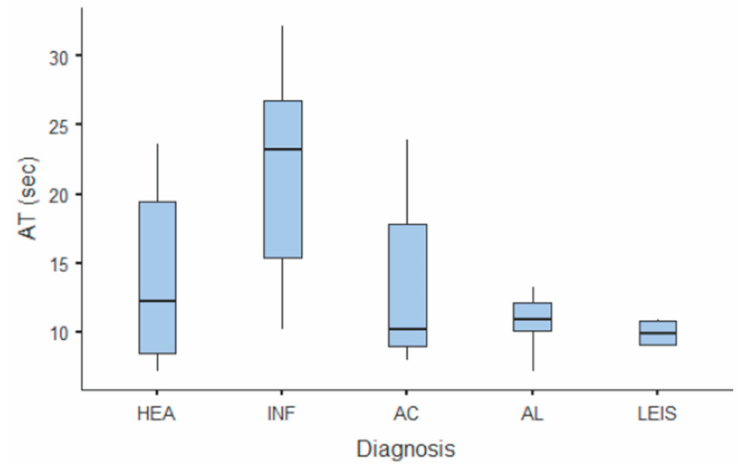
Figure 4. Box and whisker plot of the arrival time (AT) for healthy (HEA), inflammatory (INF), adenocarcinoma (AC), lymphoma (AL), and leiomyosarcoma (LEIS).